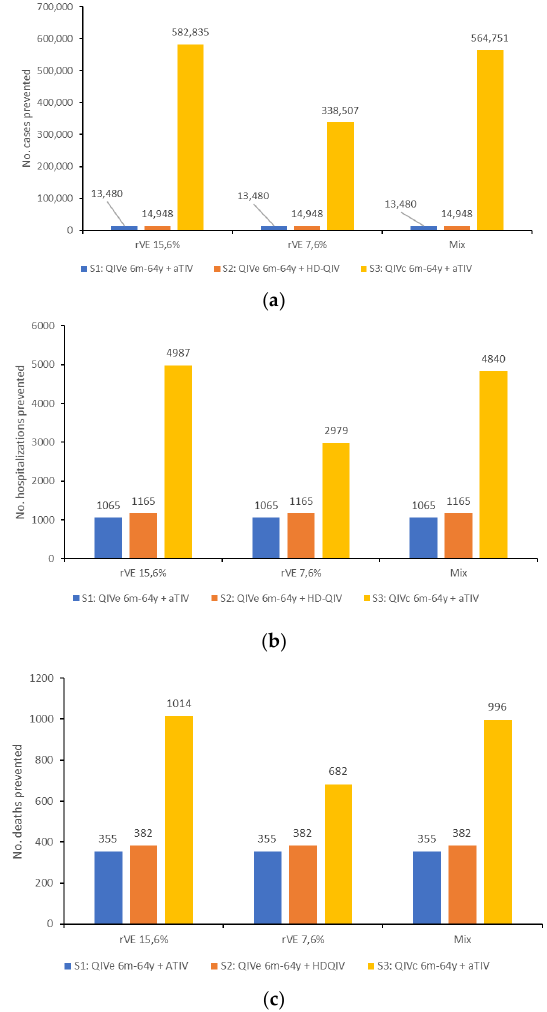
Figure 2. ( a ) Number of cases, ( b ) number of hospitalizations, and ( c ) number of deaths prevented by each vaccine scenario, compared with the baseline scenario, for each of the rVE values evaluated.